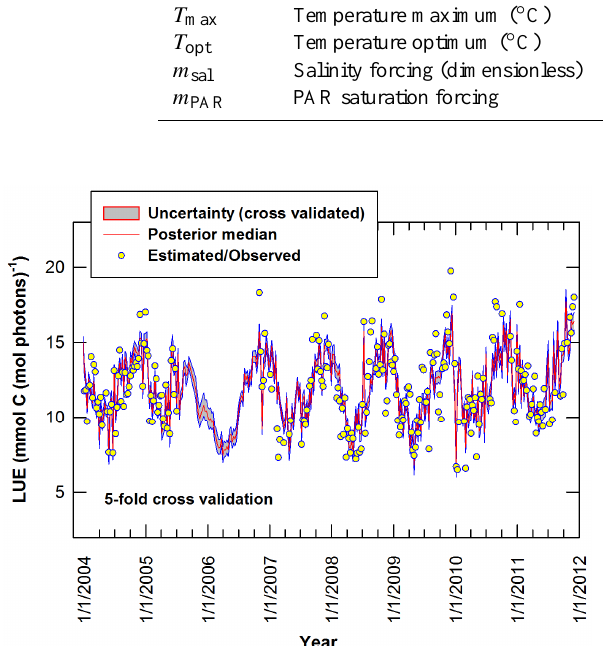
Fig. 7. Eight-day average estimated and modeled LUE (mmol C (mol photons) -1 ) at the tower site during 2004 through 2011. LUE estimates were not available from August 2005 through October 2006. The line (red) represents the posterior median LUE and shaded area represents the 2.5% and 97.5% uncertainty bounds. Uncertainties are provided for validation data sets derived from 5-fold cross validation. Modeled LUE is controlled by 8-day averages of EVI, air temperature at 27 m, and surface water salinity.